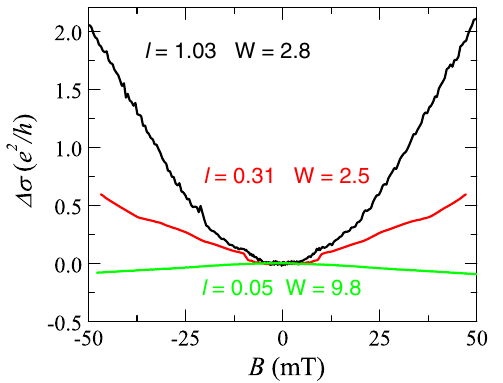
FIG. 9. Magnetoconductivity measured at high temperatures (20 – 30 K depending on the device) in the devices with different mean-free paths ( l , in μ m). The width ( W , in μ m) of the device is also